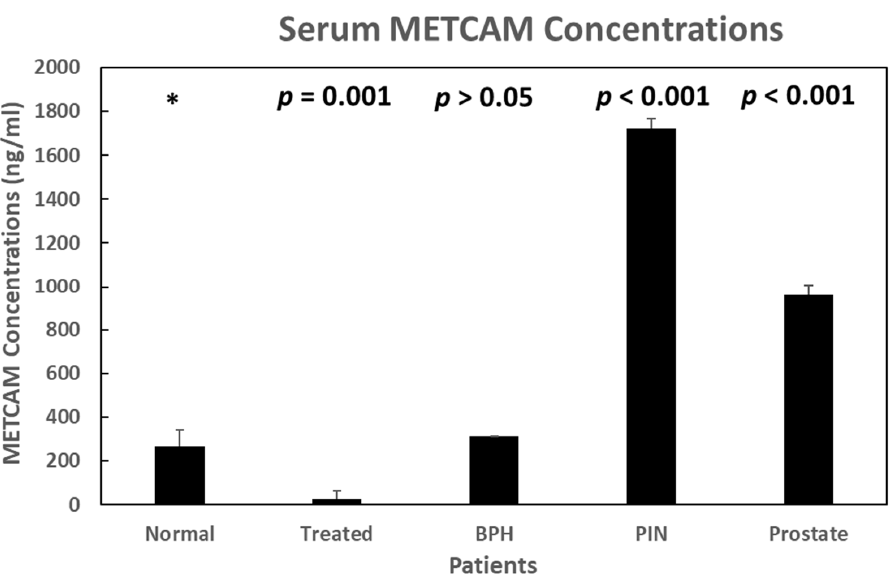
Figure 7. Serum METCAM concentrations in normal individuals and patients of BPH, PIN, prostate cancer, and treated were determined after magnetic ‐ bead purification and then followed by the modified LFIA method [46]. “*” is the reference data for statistical analysis.